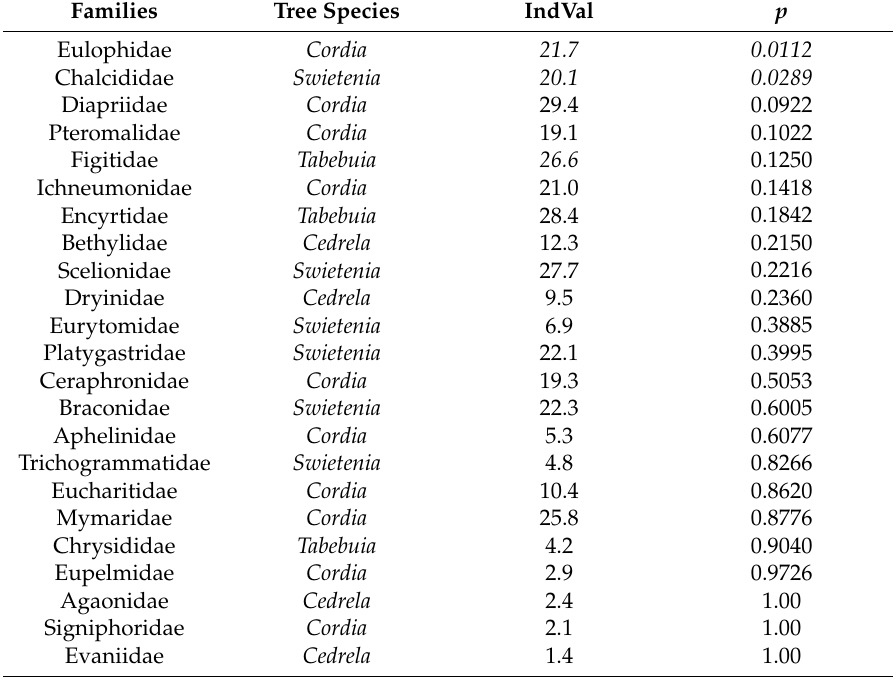
Table 5. Results obtained from the indicator species analysis in parasitoid Hymenoptera families associated to every native tree species in the study. In italics when significant ( p < 0.05). IndVal = indicator